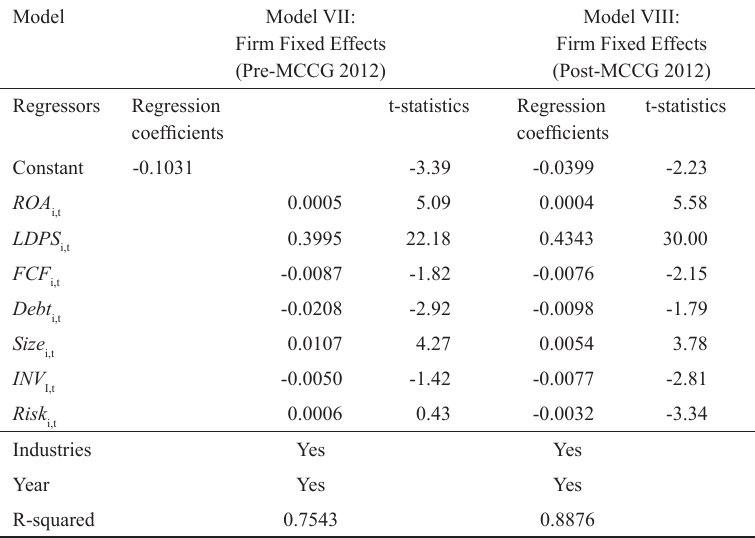
Robustness Test-Endogeneity of Omitted Variables